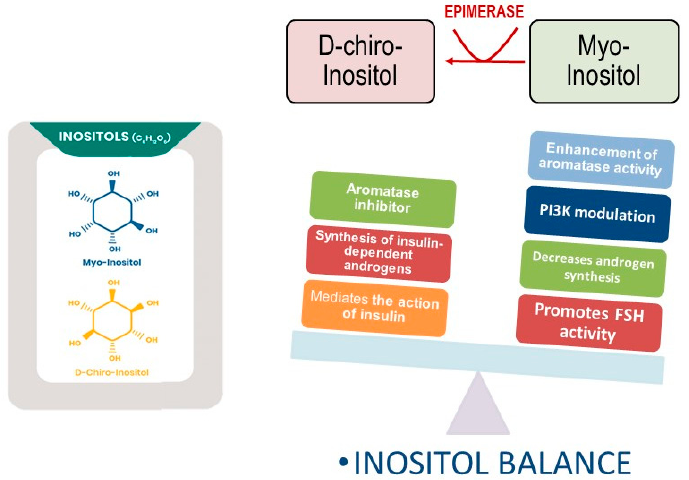
Figure 2. Opposite functions exerted by myo-inositol and D-chiro-inositol. D-chiro-Ins inhibits aromatase synthesis and increase androgen synthesis under insulin stimulation. Myo-Ins modulates PI3K activity, while enhancing aromatase and FSH-receptor synthesis in granulosa cells. Moreover, myo-Ins decreases androgen release from theca cells.